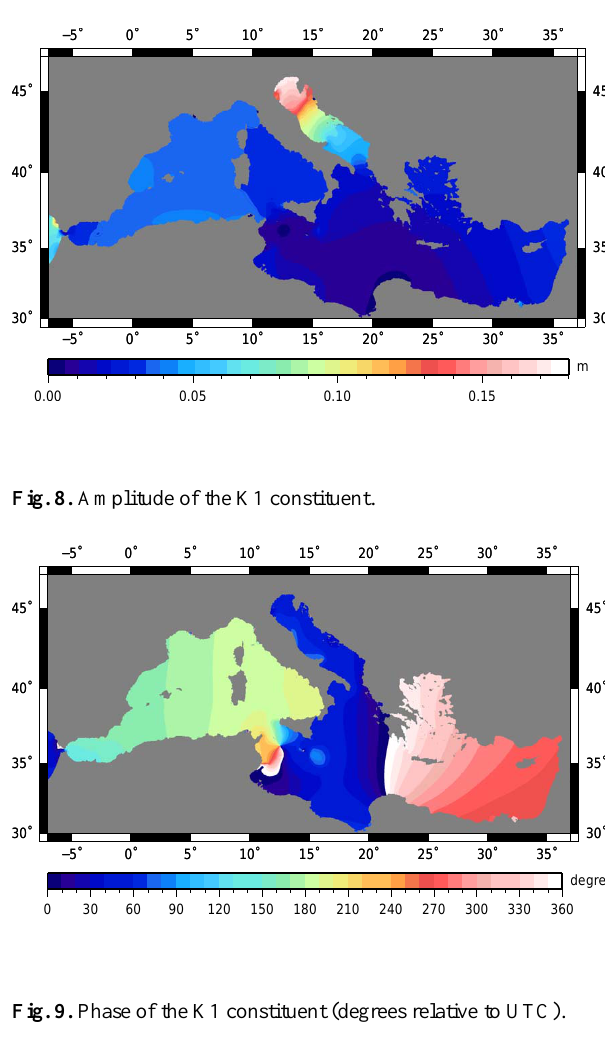
Fig. 9. Phase of the K1 constituent (degrees relative to